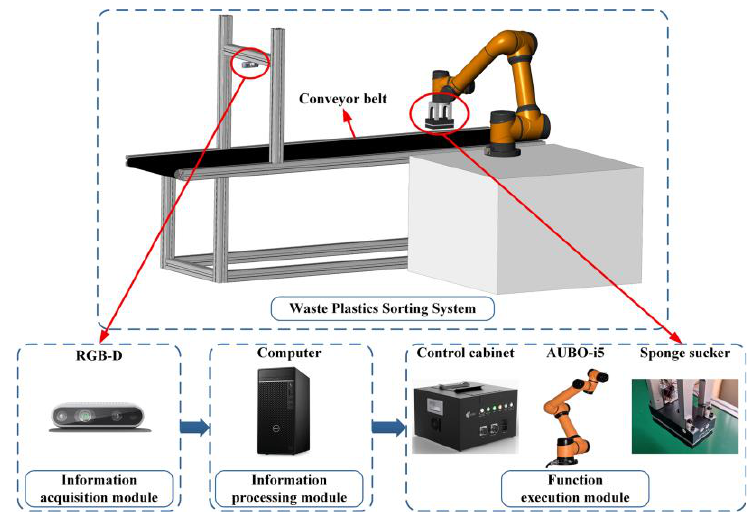
Figure 2. Waste plastics sorting